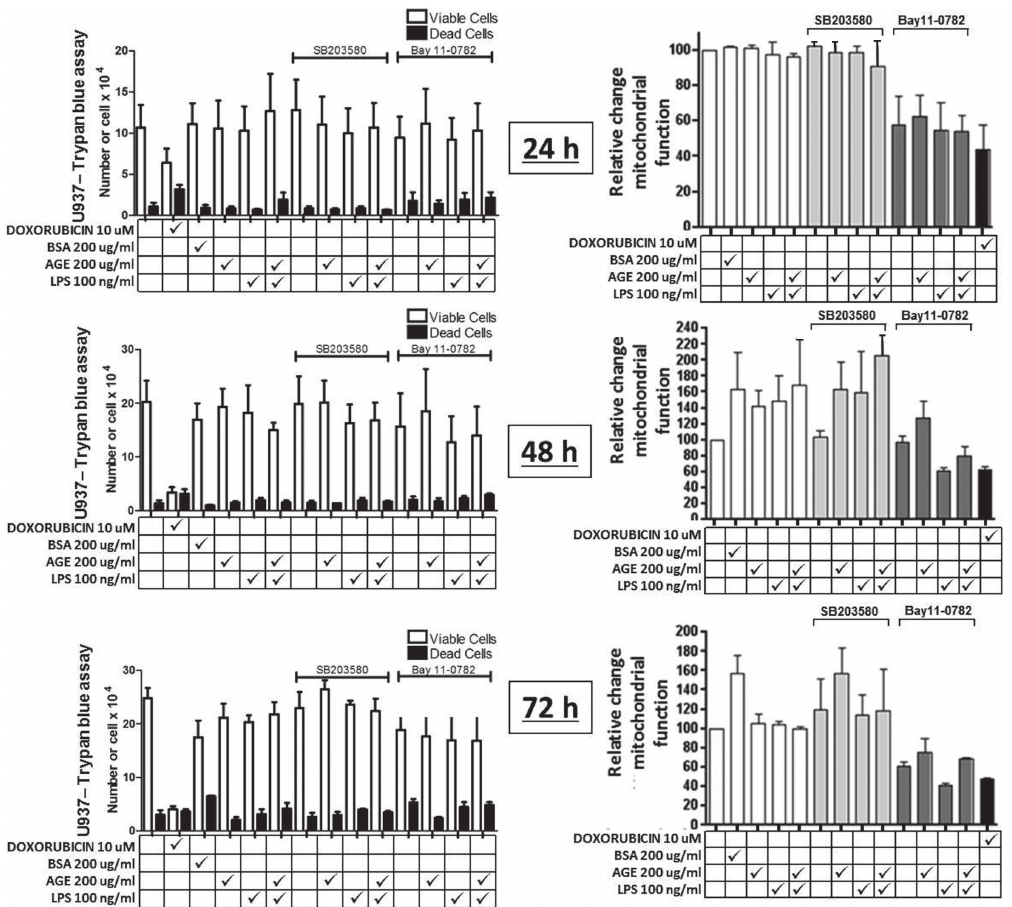
Figure 2- Modulation of cell death in the U937 (monocyte) cell lineage. Right column corresponds to Trypan Blue Test, and left column to MTS assay. The cell line was stimulated for 24, 48 and 72 hours with E. coli LPS (100 ng/mL) with or without AGE-BSA (200 µg/mL) in the presence and absence of p38 MAPK inhibitors (SB203580, 10 µM) and NF-kB (Bay 11-7082, 10 µM). Bars indicate mean±standard deviation of three independent